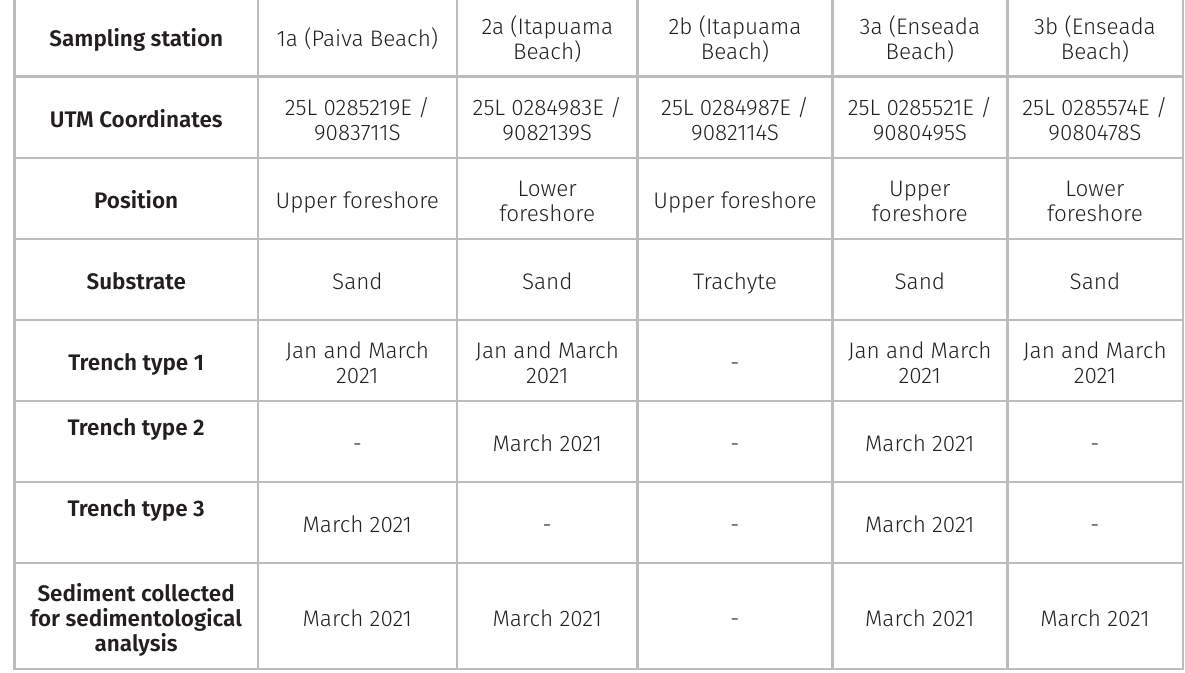
Table I. Sampling station characteristics, location, and type of trenches excavated in the temporal analysis. Sampling